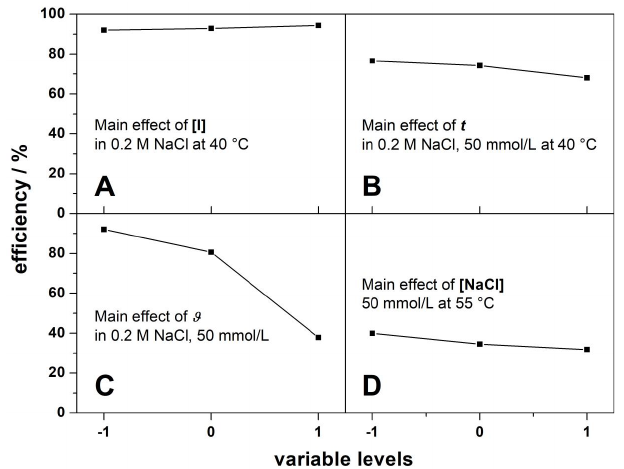
Figure 1. General effects of the four selected variables [I], t , ϑ , and [NaCl] with their three levels ( − 1, 0, and +1) on the corrosion protection of steel CR4: Main effect on the process ( A ) of [I], ( B ) of t , ( C ) of ϑ , and ( D ) of [NaCl], respectively, while the other tested variables remain